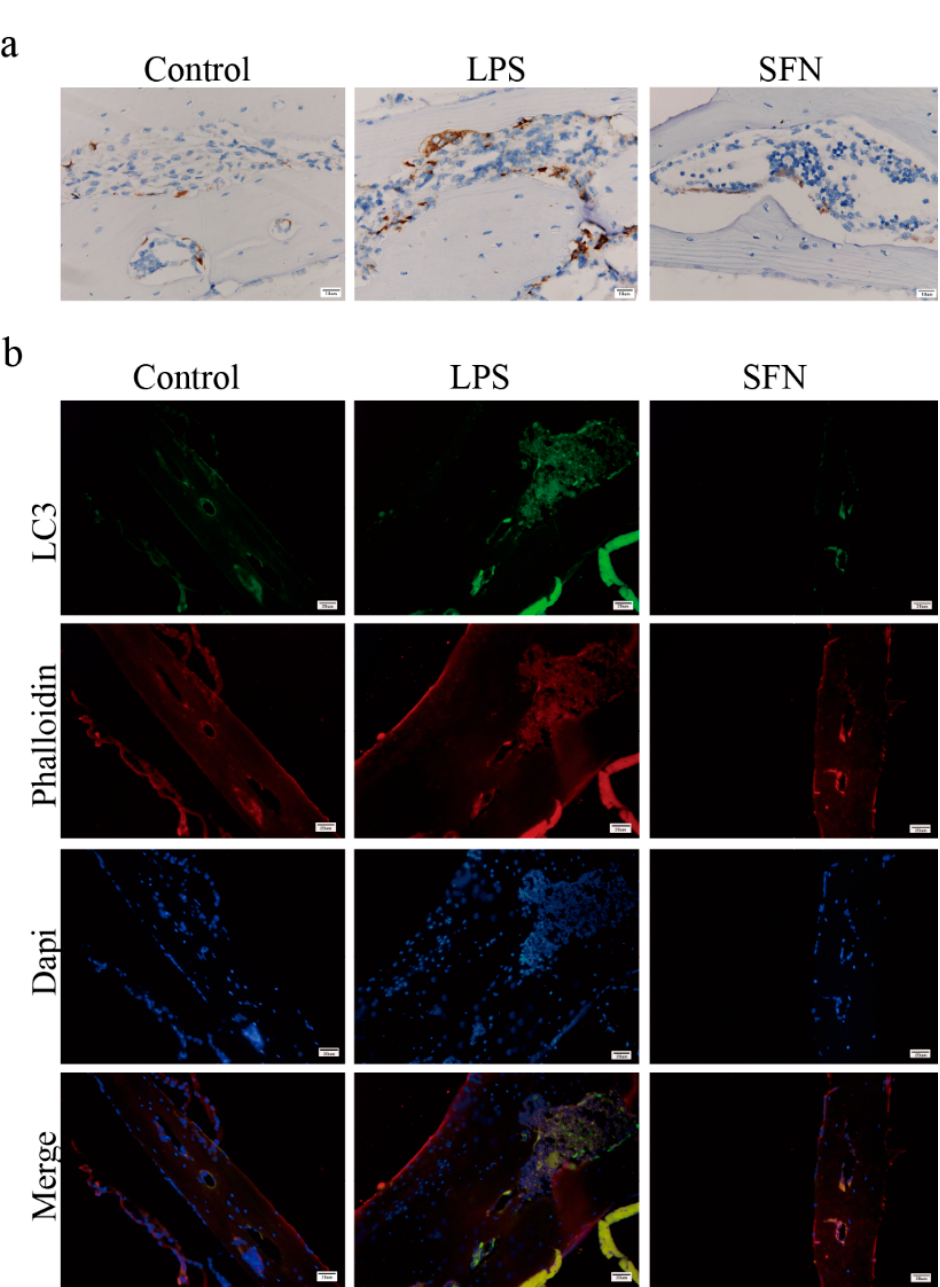
Figure 6. The administration of SFN attenuated autophagic LC3 expression in an LPS-induced mouse calvaria model. Calvarias were fixed, decalcified, dehydrated, embedded, and sectioned. ( a ) Representative IHC images locating LC3. ( b ) Representative IF images of the distribution of LC3 (green). Phalloidin (red) indicates cytoskeleton and bone. DAPI (blue) was used to counterstain the nuclei.